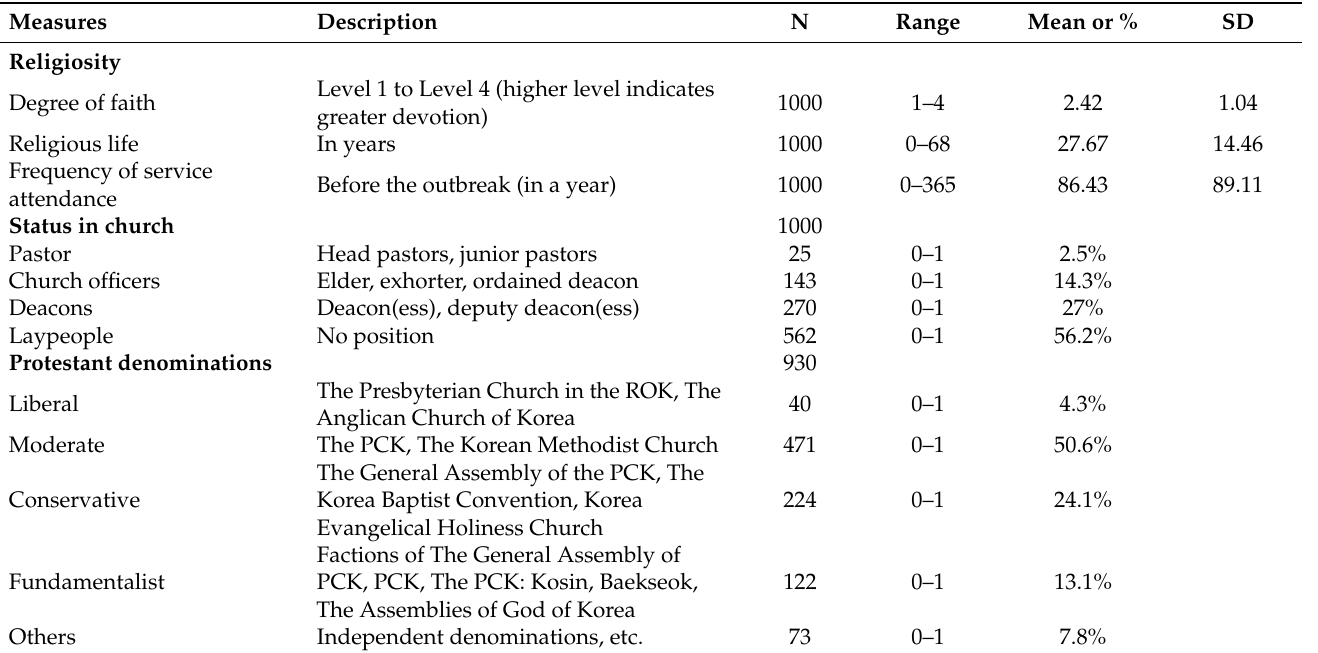
Table 10. Descriptive statistics for key independent